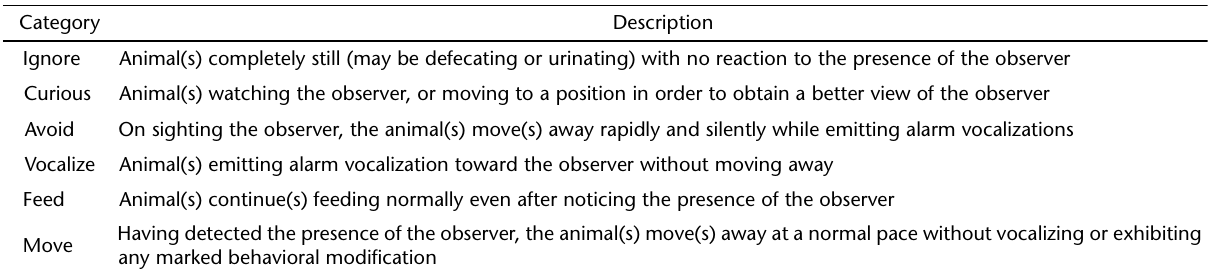
Table I. Categories of the behavioral response of unhabituated titis to the presence of human observers (adapted from B LOM et al. 2004). Category